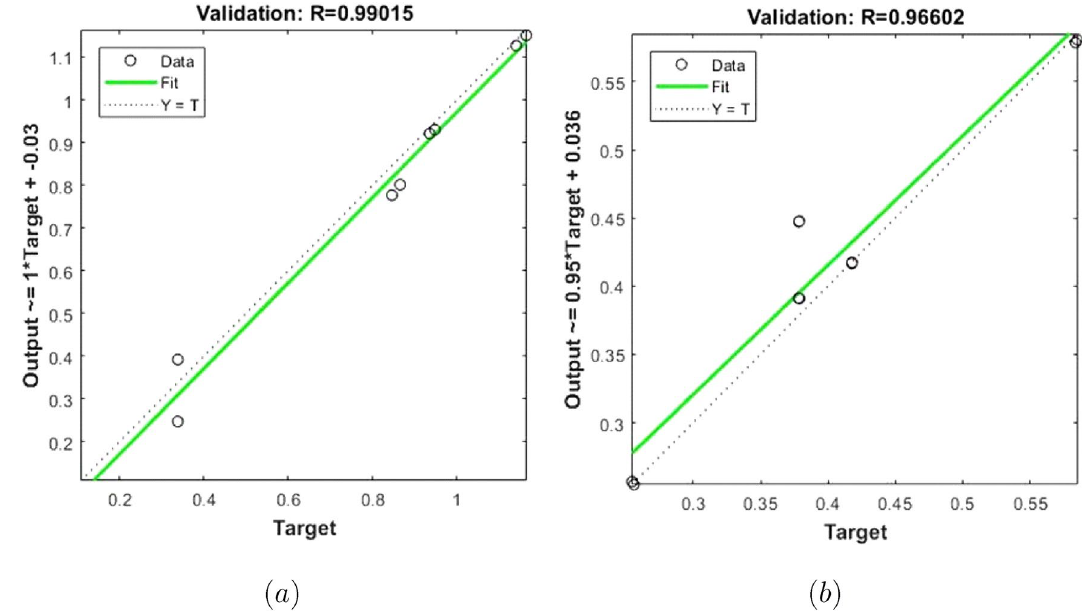
Figure 18. Validation data ( a ) Skin Friction Coefficients ( b ) Nusselt Number.